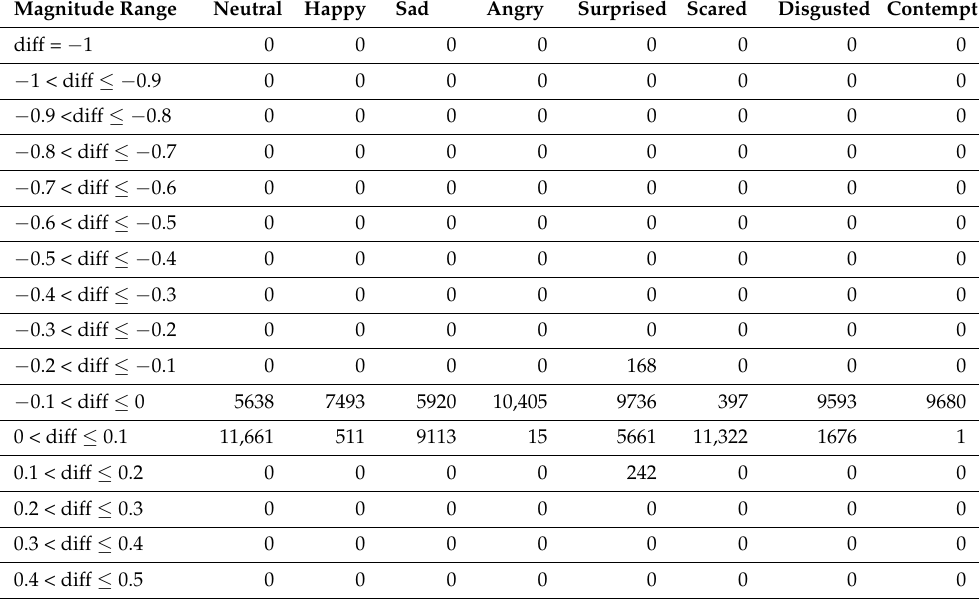
Table A3. Example distributions of test 1 –test 2 differences, with corresponding means, separately for the 8 emotions: subject #2 (ASD). Test 2 –test 3 data for subject #2 were identical. Frequency distributions include only data points with intensity values assigned in both test 1 and test 2 (therefore numerical difference could be calculated); however, matching data points with zero difference were omitted. Nonzero percent row shows the relative frequencies of mismatching data points for each emotion. As emotion intensities are scaled from 0 to 1 by FR8, the difference between two corresponding data points ranges between − 1 and 1; in absolute value between 0 and